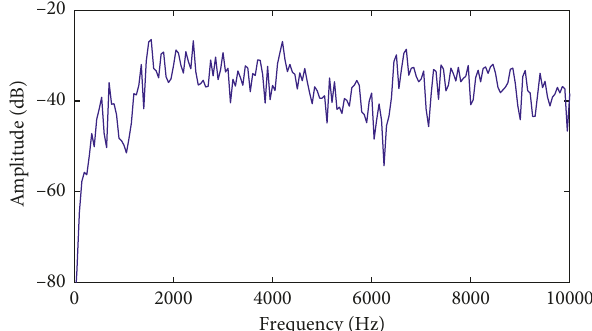
Figure 11: Calculated combustion noise transfer function by